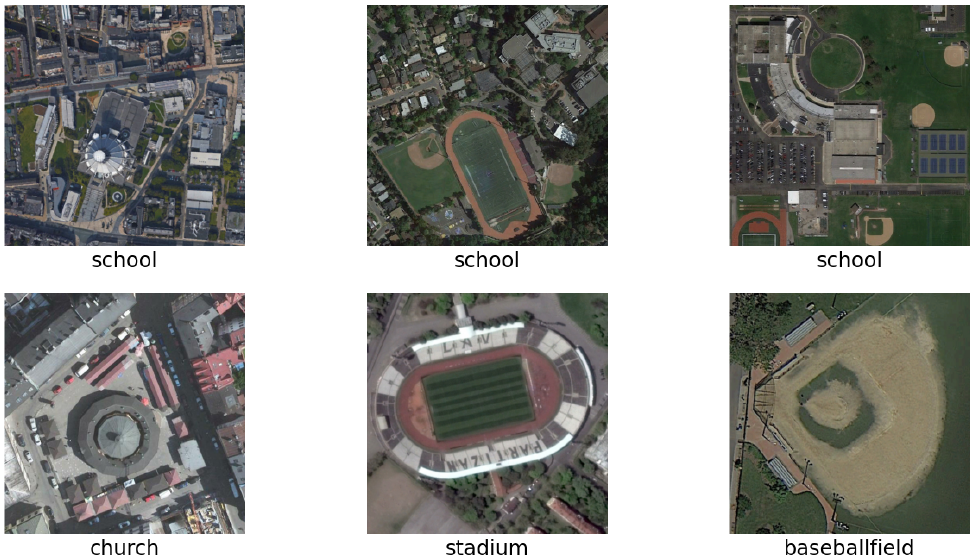
Figure 1. The figure shows the inter-class similarity and intra-class variability of remote sensing